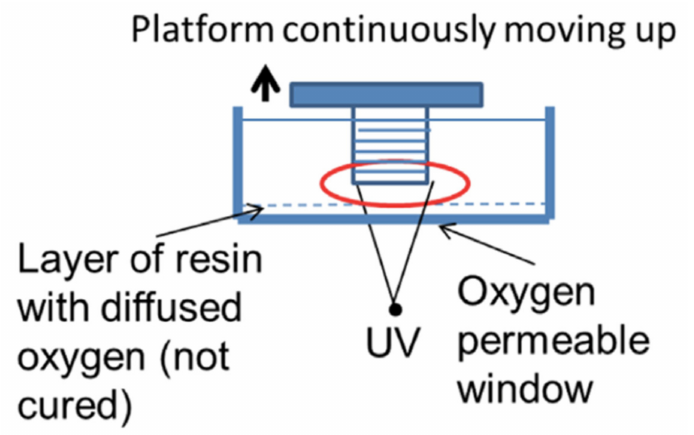
Figure 7. Continuos liquid interface production [148]. Reprinted with permission from ref. [148]. Copyright 2021